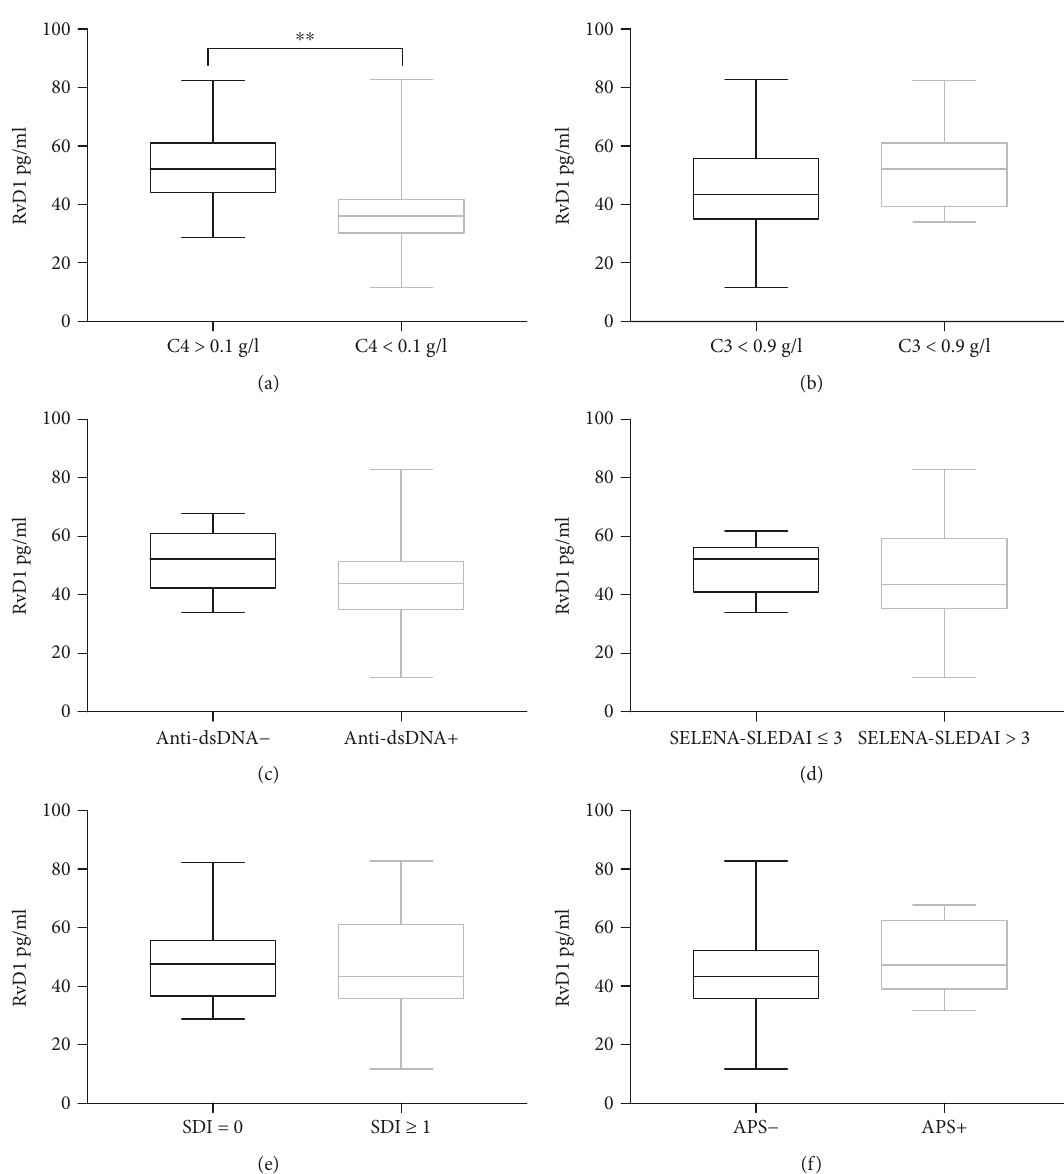
Figure 3: (a) Levels of resolvin D1 (RvD1) in plasma from SLE patients with low C4 levels ( < 0.1g/l) ( N = 10 ) and SLE patients with normal C4 levels ( > 0.1g/l) ( N = 20 ). (b) Levels of resolvin D1 (RvD1) in plasma from SLE patients with low C3 levels ( < 0.9g/l) ( N = 19 ) and SLE patients with normal C4 levels ( > 0.9 g/l) ( N = 11 ). (c) Levels of resolvin D1 (RvD1) in plasma from anti-dsDNA antibody-positive SLE patients ( N = 18 ) and anti-dsDNA antibody-negative SLE patients ( N = 12 ). (d) Levels of resolvin D1 (RvD1) in plasma from SLE patients with SELENA-SLEDAI ≤ 3 ( N = 10 ) and SLE patients with SELENA-SLEDAI > 3 ( N = 20 ). (e) Levels of resolvin D1 (RvD1) in plasma from SLE patients with SDI=0 ( N = 15 ) and SLE patients with SDI ≥ 1 ( N = 15 ). (f) Levels of resolvin D1 (RvD1) in plasma from SLE patients without antiphospholipid syndrome (APS) ( N = 21 ) and SLE patients with APS ( N = 9 ). Data are expressed as pg/ml, median (horizontal bar) with 25th and 75th percentile (boxes), and minimum and maximum (bars) ( ∗∗ p = 0 0087